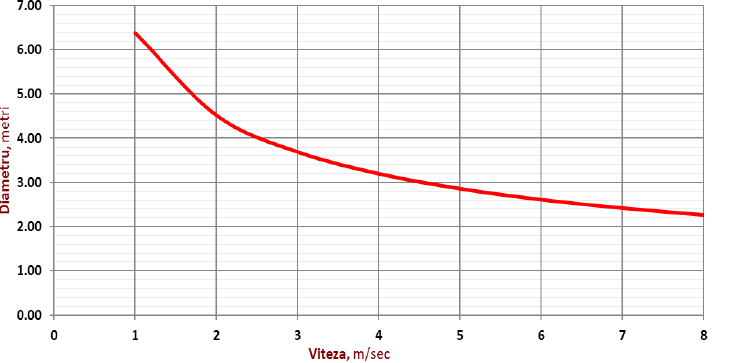
Figure 9. Dimensions of the upper reservoir